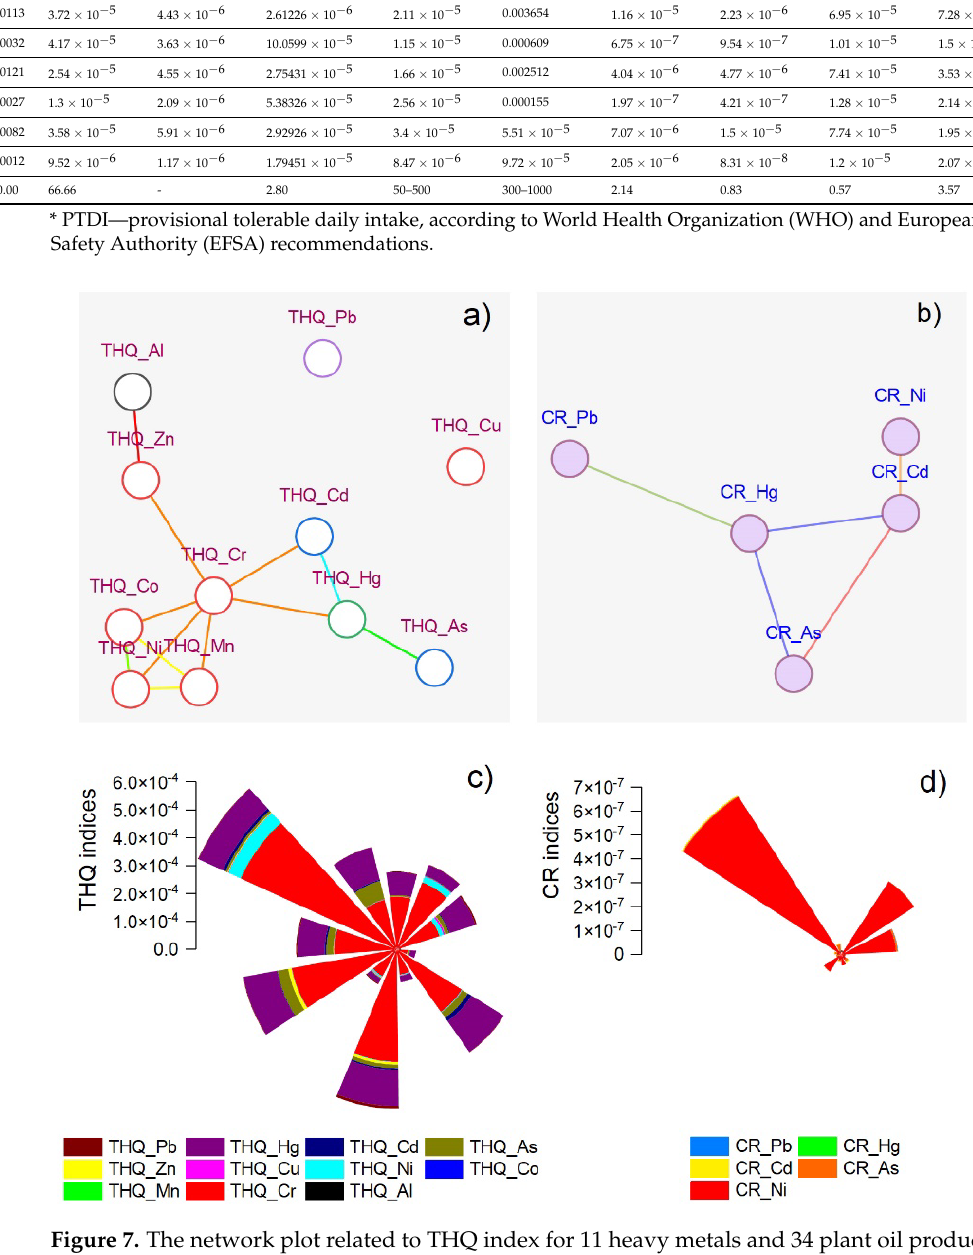
Figure 7. The network plot related to THQ index for 11 heavy metals and 34 plant oil products ( a ); Hazard Index (HI) resulted by summing the target hazard quotient (THQ) for each metal presented in panel ( c ); The network plot related to CR index for 11 heavy metals and 34 plant oil products ( b ); Total cancer risk calculated by summing the cancer risk for each metal presented in panel ( d ). The network plot shows the involvement of each heavy metal inclination in inducing risk for human consumers. Three groups were calculated for THQ, including As, Hg, and Cd in the first group. In the second were Cr, Mn, Ni, Co, and in the third were associated Zn and Al. The correlation matrices indicated significant THQ values between Al‒Zn ( r = 0.64), Cr‒Mn ( r = 0.67), Cr‒Co ( r = 0.72), Cr‒Ni ( r = 0.63), Cr‒Hg ( r = 0.58), Mn‒Co ( r = 0.97), Mn‒Ni ( r = 0.95), Co‒Ni ( r = 0 .96), As‒Hg and Cd‒Hg ( r = 0.63) (Figure 7a). For CR, we observed a single cluster including toxic metals Hg, Cr, and As. The significant correlation coefficients were calculated only between Cd‒Hg and As‒Hg (0.63) (Figure 7b). The re- sults indicated possible cumulative effects of toxic metals that increase the risk for human consumers.